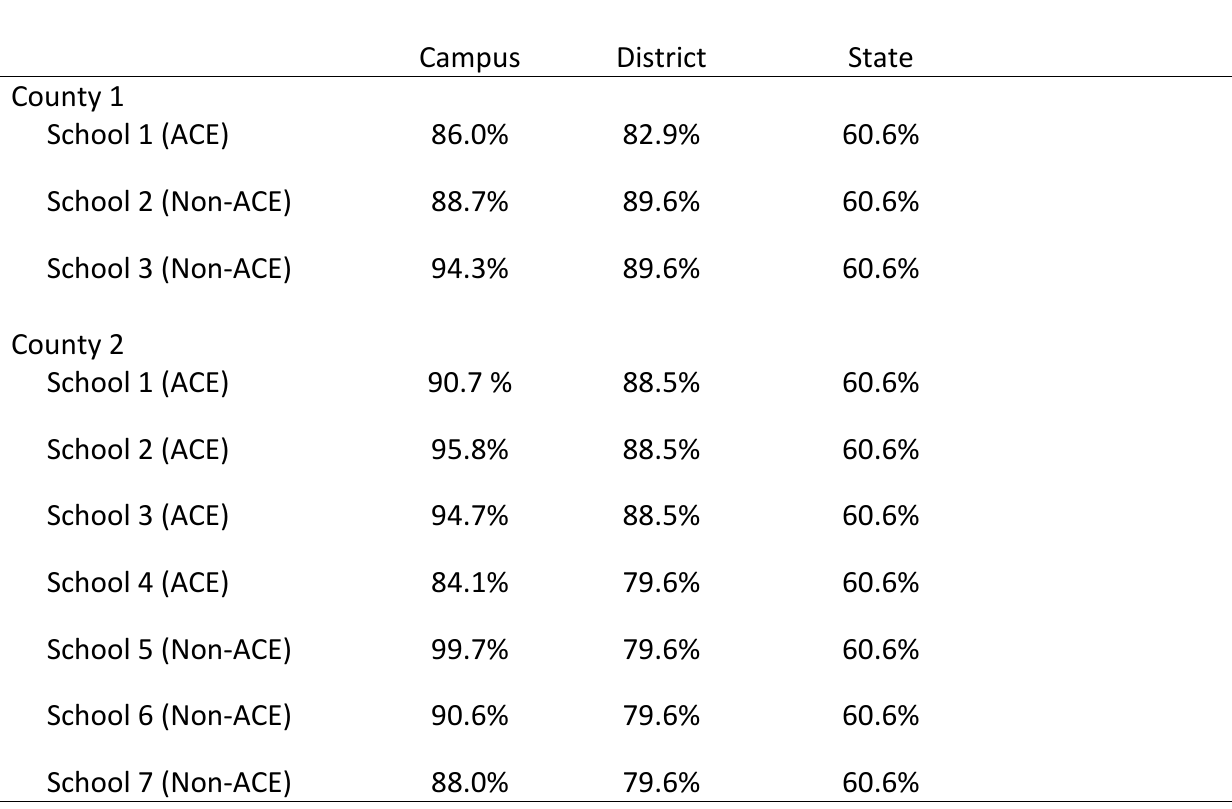
Table 3 : Descriptive Statistics on Percent of Economically Disadvantaged Student Enrollment at Studies